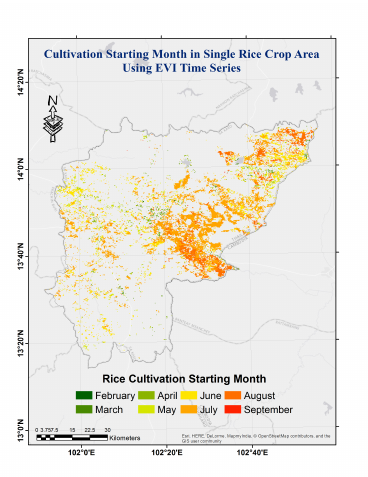
Figure 8: Rice Crop Intensity map from NDVI in Sa Kaeo Province, Thailand)